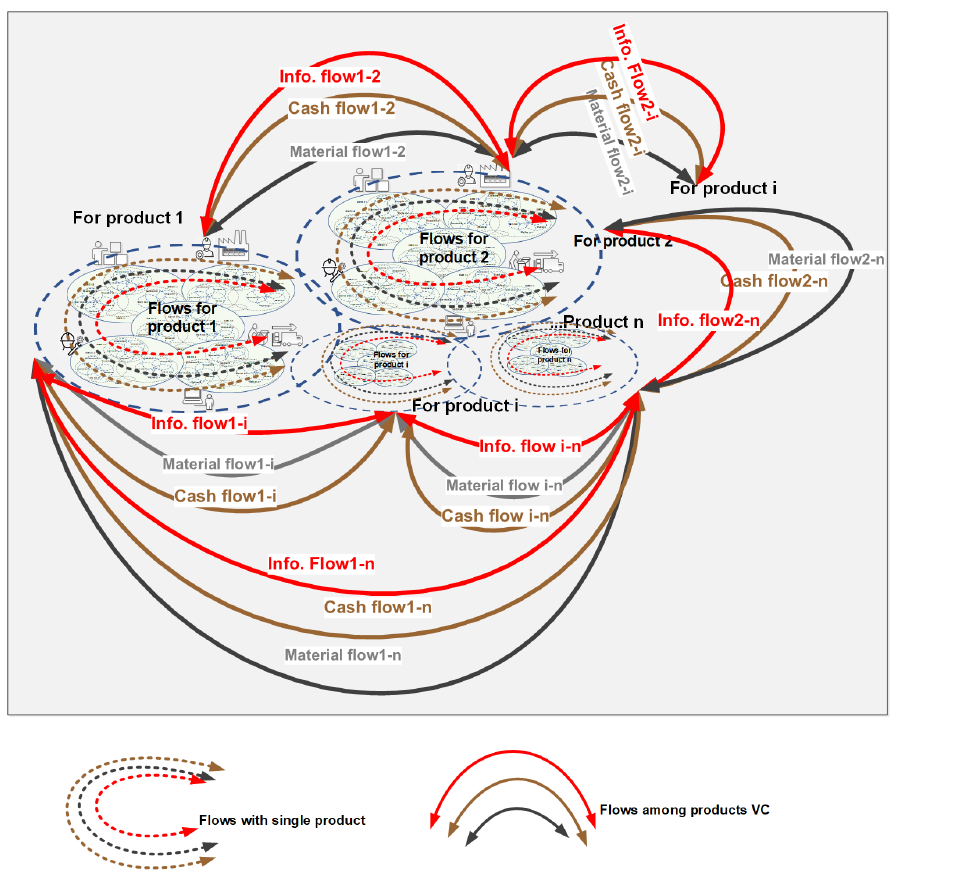
Figure 5. Flow-networks of the SocialVC